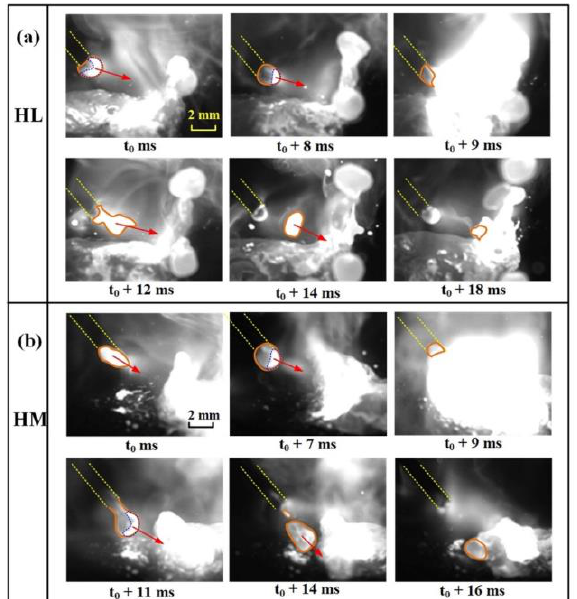
Figure 15. The influence of different heat source-leading modes in the welding process: ( a ) HL mode, ( b ) HM mode [75]. Reprinted with permission from [75] 2022 Elsevier.